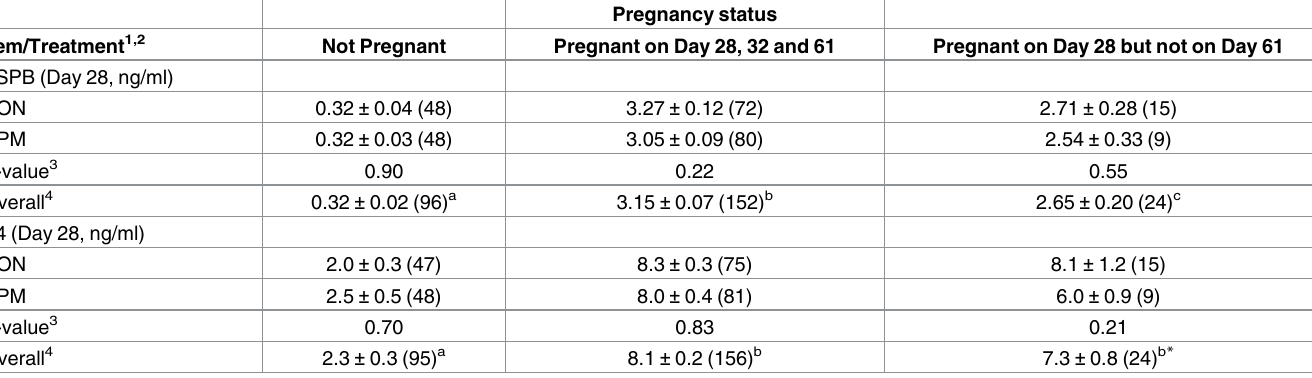
Table 5. Effect of rumen-protected methionine (RPM) feeding on Pregnancy-specific protein (PSPB) and progesterone (P4) concentrations on Day 28 in cows not pregnant, pregnant on Days 28, 32, and 61, or pregnant on Day 28 that subsequently lost their